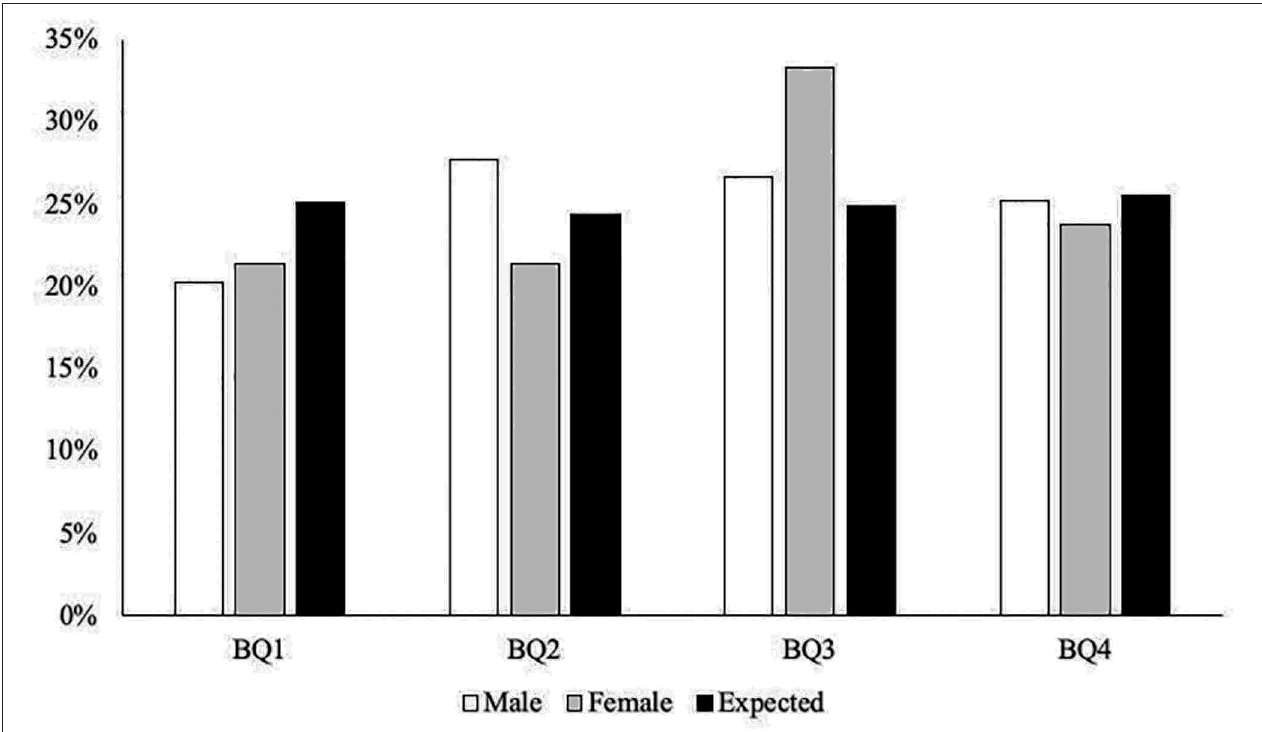
FIGURE 3 | The distribution of BQs in male and female combined cohorts and expected distribution of national norms (Office for National Statistics, 2015).